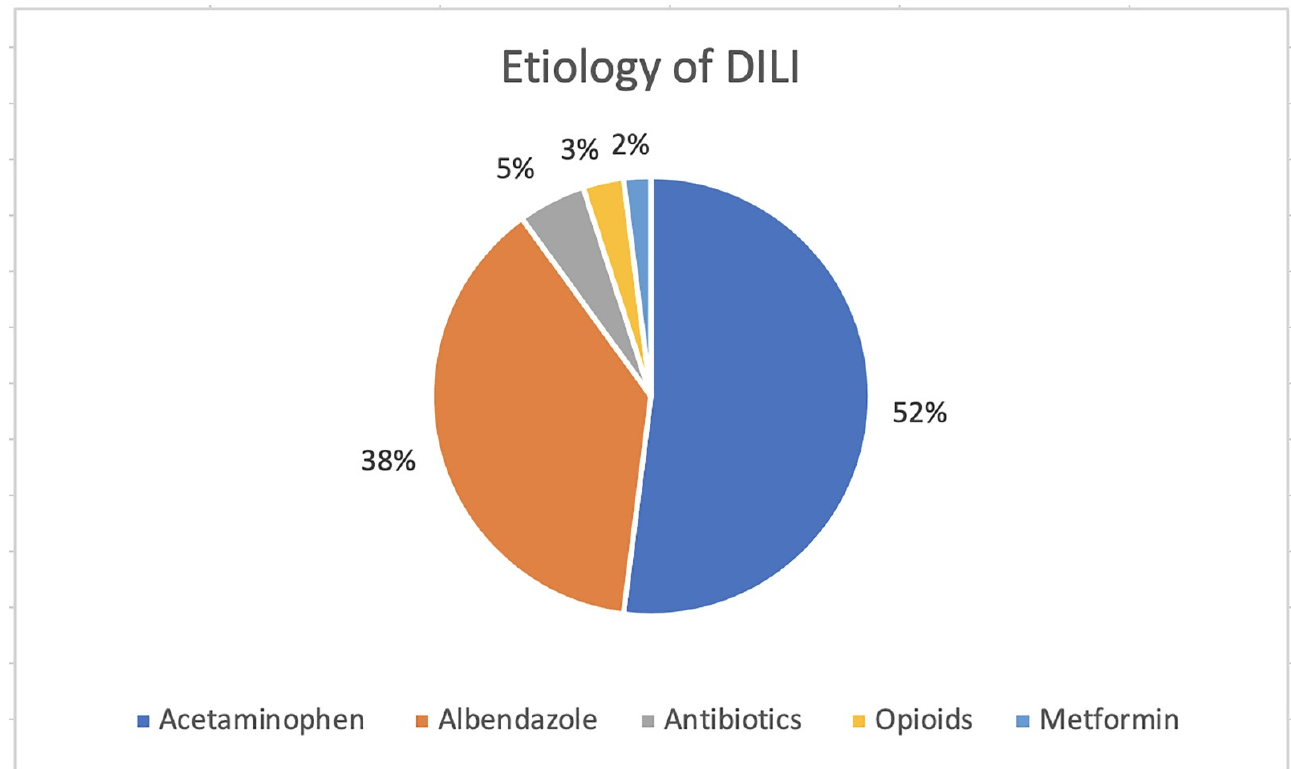
Figure 1. Etiology of DILI.